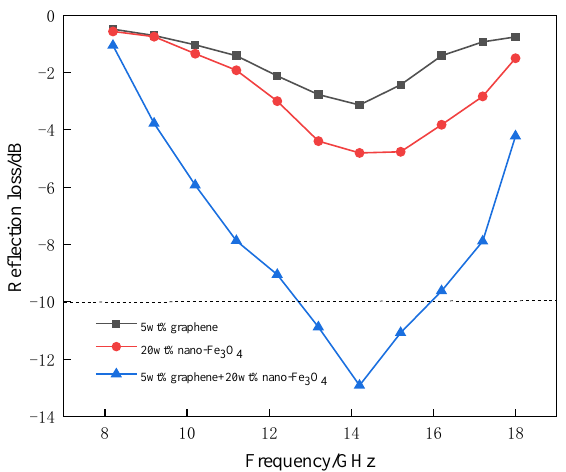
Figure 8. Reflection loss of composite absorbers with different absorbing agent composition.